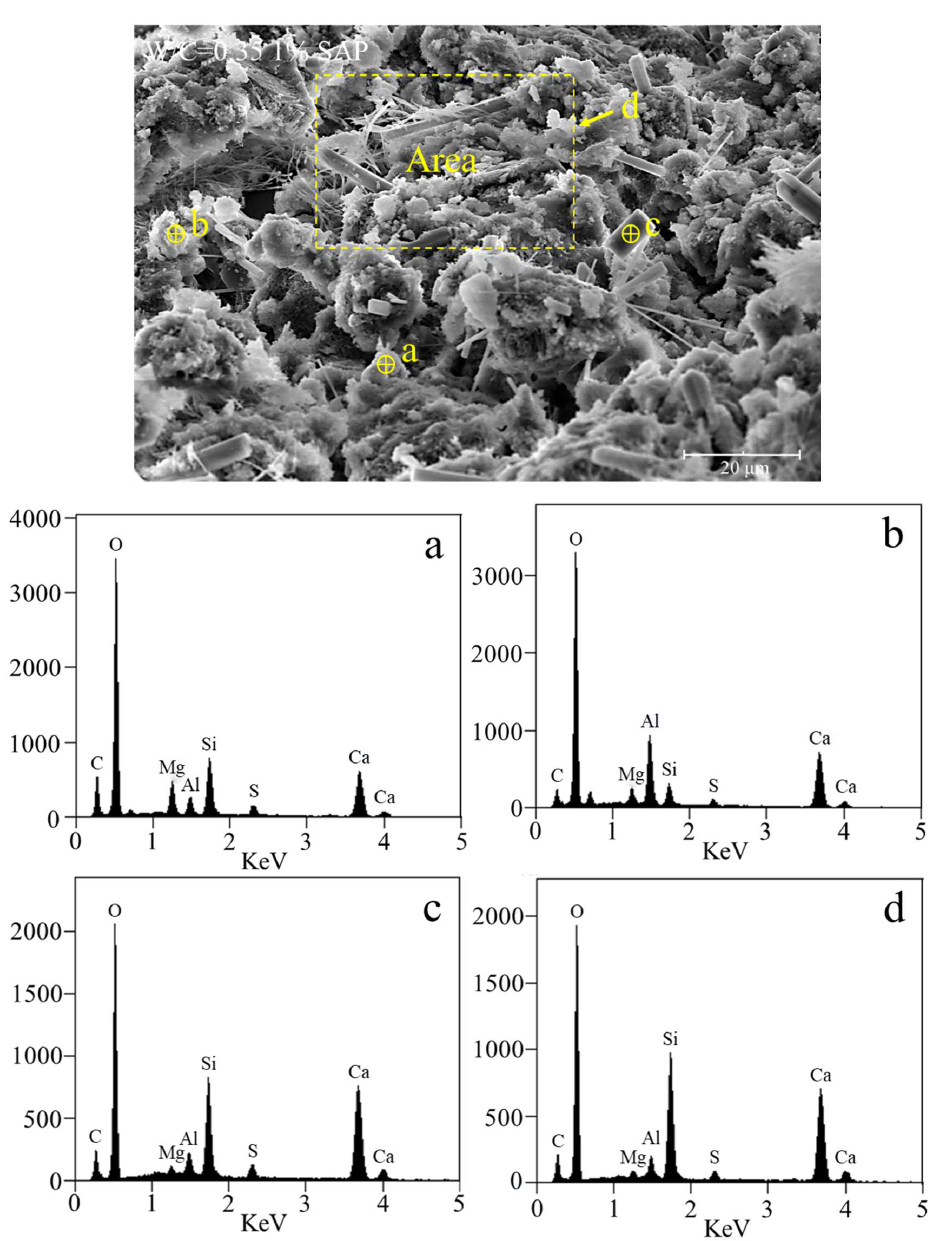
Figure 11. The EDS analysis of the samples with the W/C ratio of 0.35 at 28 d: ( a ) EDS curve of point a, ( b ) EDS curve of point b, ( c ) EDS curve of point c, ( d ) EDS curve of area d.